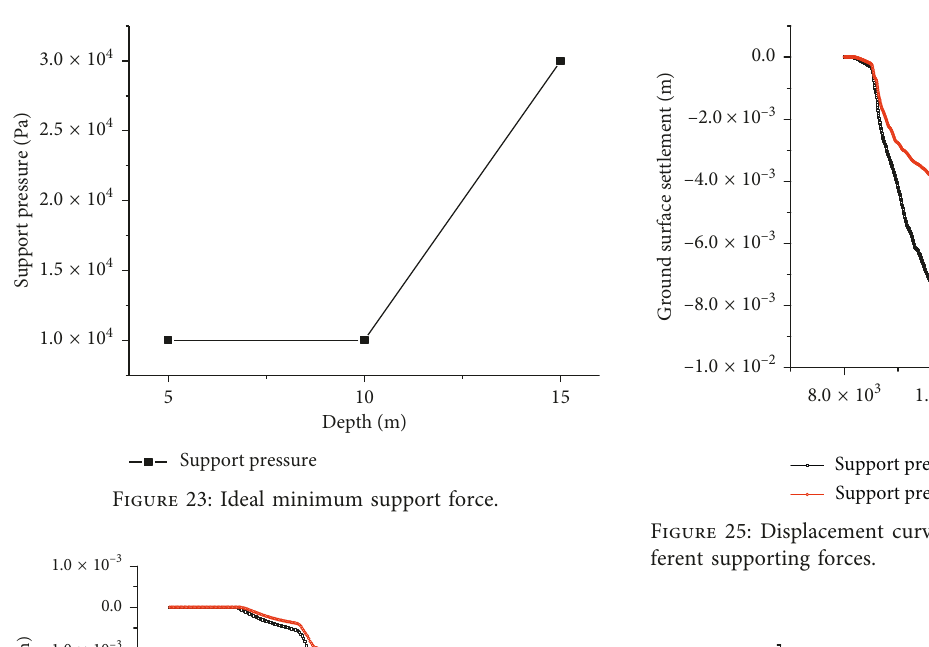
Figure 22: Convergence curves of surface subsidence.